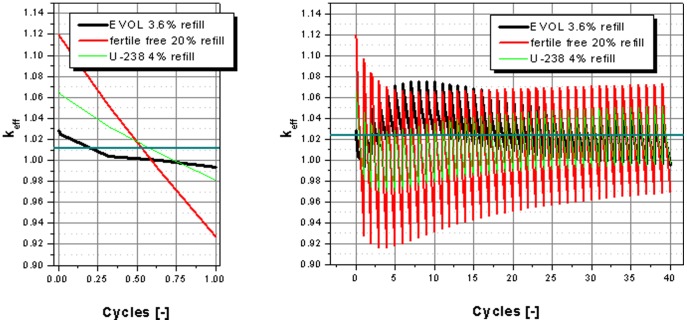
Comparison of the keff evolution over the first cycle (left) and over the operational period of 40 cycles (right).